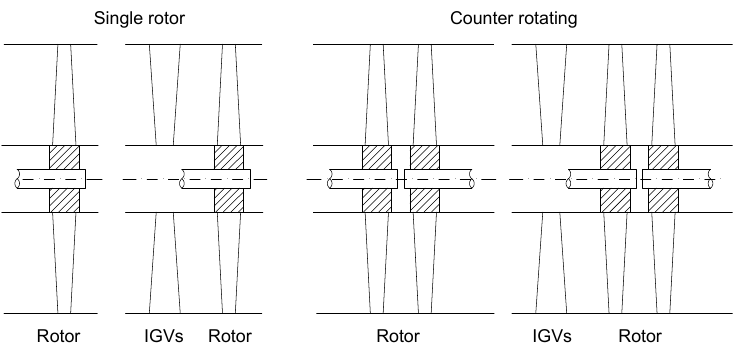
Figure 3. Schematic drawing of turbine layouts, adapted from